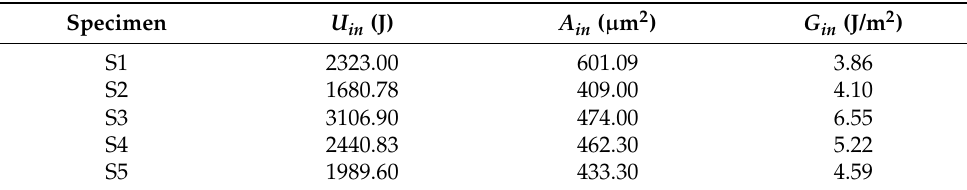
Table 3. Values of energy release from interfacial delamination (U in ), delamination area (A in ), and toughness (G in ) of the SiN/GaAs interface.